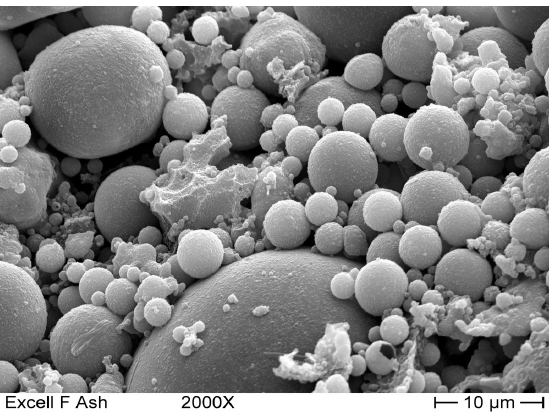
Figure 3. Magnified image of FA particles (reproduced with permission of Petra Buildcare Products [102],